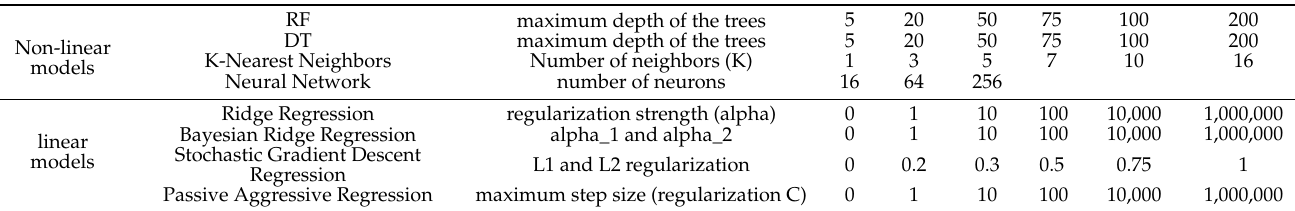
Table 4. MODELING PARAMETERS OF THE